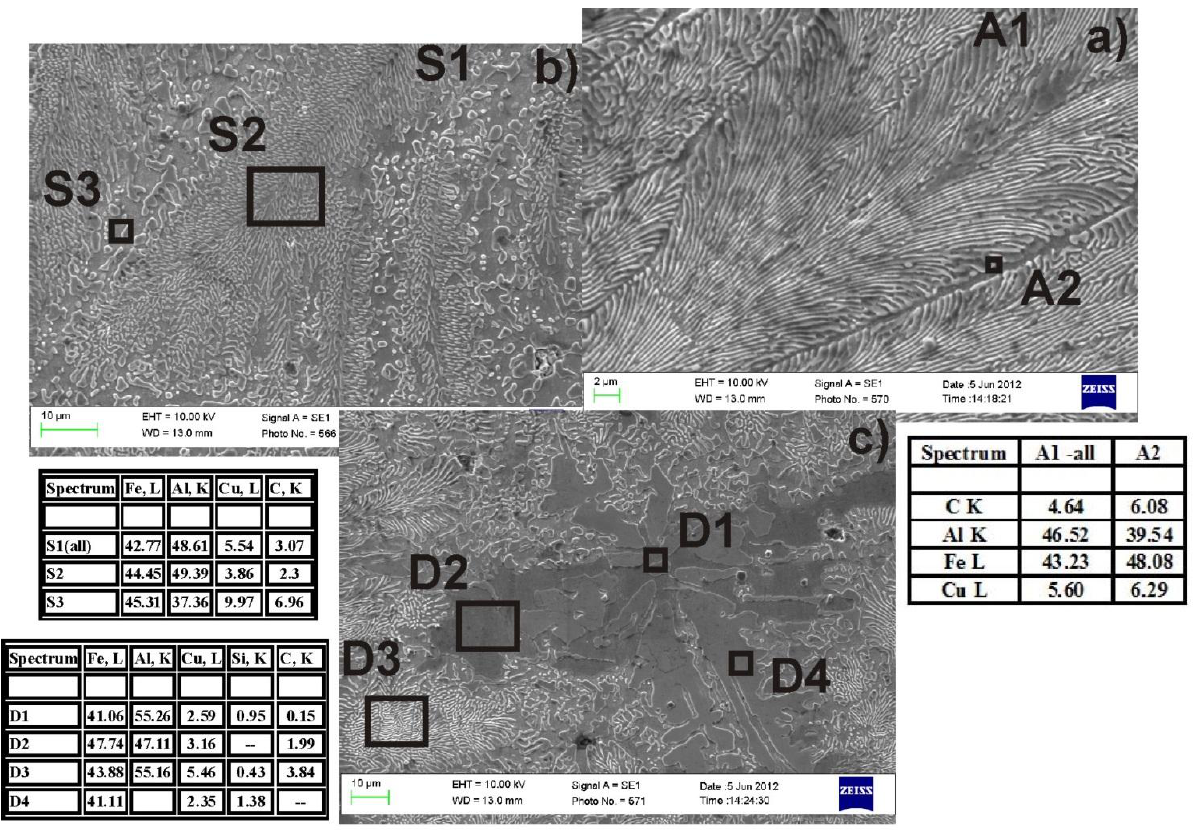
Figure 7. SEM micrographs showing typical solidification microstructures of the top clad coatings with EDS results of Fe–Al multilayer